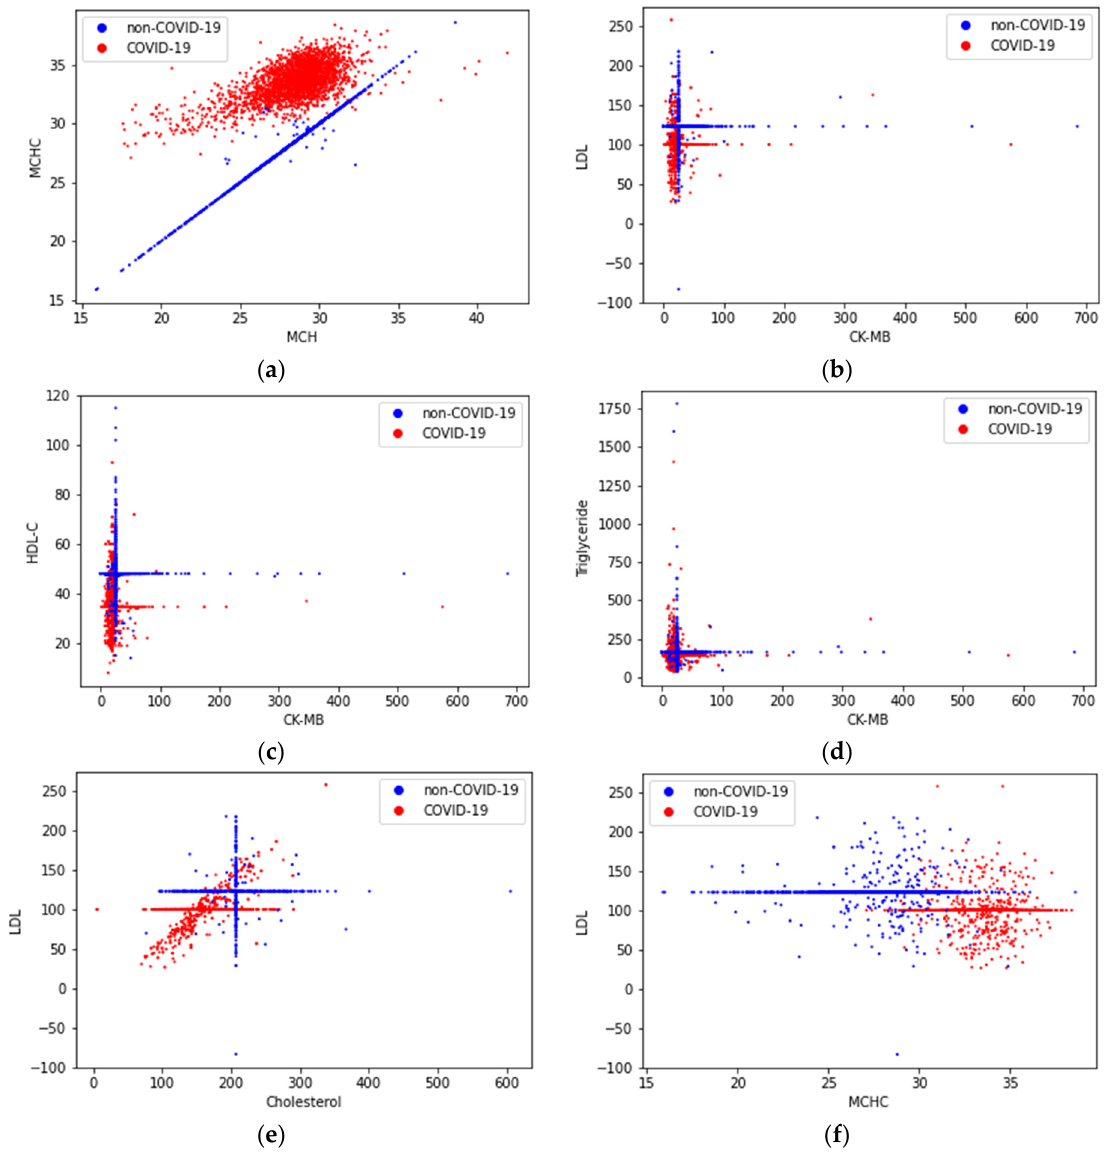
Figure 7. Two-dimensional distributions (attractors) of a COVID-19 and non-COVID-19 diagnosis in the coordinates of feature pairs MCHC–MCH ( a ), LDL–CK-MB ( b ), HDL-C–CK-MB ( c ), Triglyceride–CK-MB ( d ), LDL–Cholesterol ( e ), LDL–MCHC ( f ).